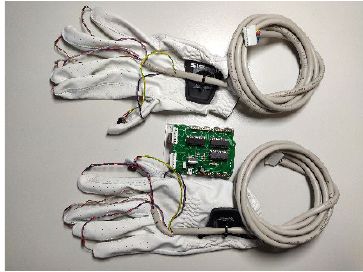
Figure 1. Haptic gloves.